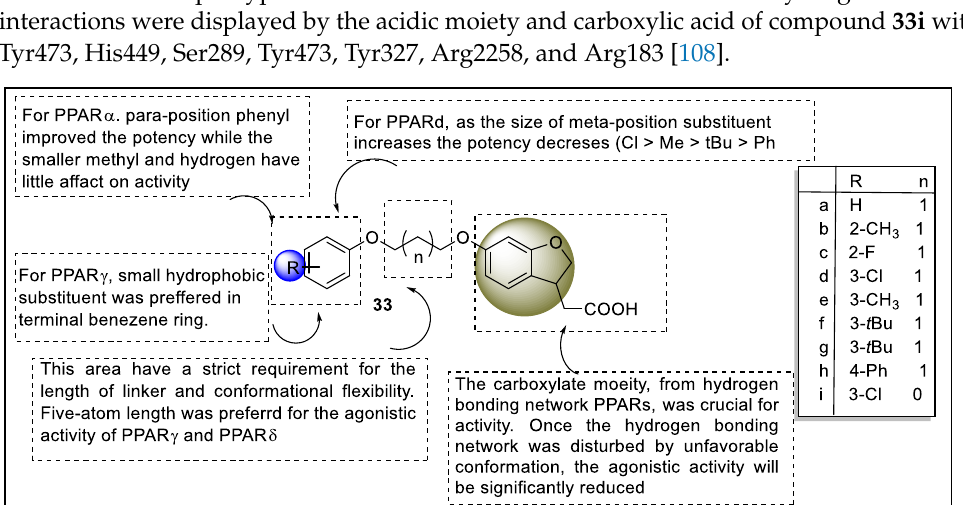
Figure 38. Structural activity relationship of Furan hybrids ( 34 ) as potent PPAR ligands. Liu et al. synthesized a series of novel dual PPAR- α/δ agonists to target PPARs. The in vitro evaluation revealed that the compound substituted with trifluoro carbon pos- sessed high potency toward PPAR- α/δ (0.26 ± 0.08 μM 0.50 ± 0.10 μM) and higher selec- tivity against PPARγ (− 4.22 ± 0.18 µM) than that of GFT505 (Figure 39). The molecular docking studies a lso showed considerable binding affinity towards LBD of PPARα/δ com- pared to GFT505 that displayed H-bond interactions between the ligand and important amino acids such as Tyr314, His 440, Ser 280, and Tyr464. Moreover, H-bond interactions were displayed between the ligand and His 287, His 413, Thr252, Thr437, and Tyr253 of PPAR δ [110].